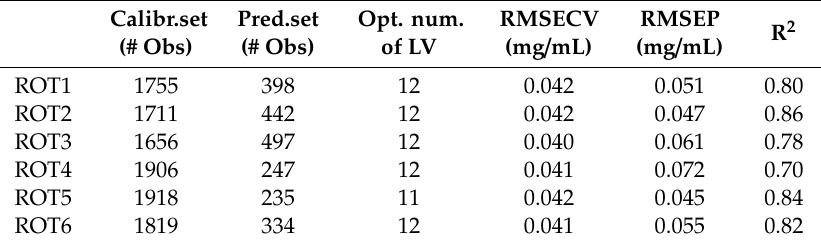
Table 3. Data set information and PLS modeling results of all